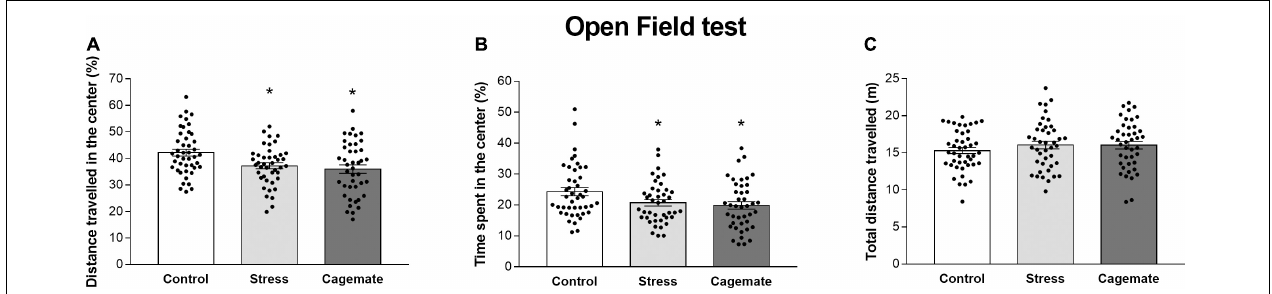
FIGURE 2 | All data are presented as mean ± SEM. (A) Percentage of distance traveled, (B) percentage of time spent in the center of the open field, and (C) the total distance traveled ( n = 42–44 per group) during the 5-min test. * p < 0.05 vs. control group. One-way ANOVA was followed by Newman-Keuls post hoc test.